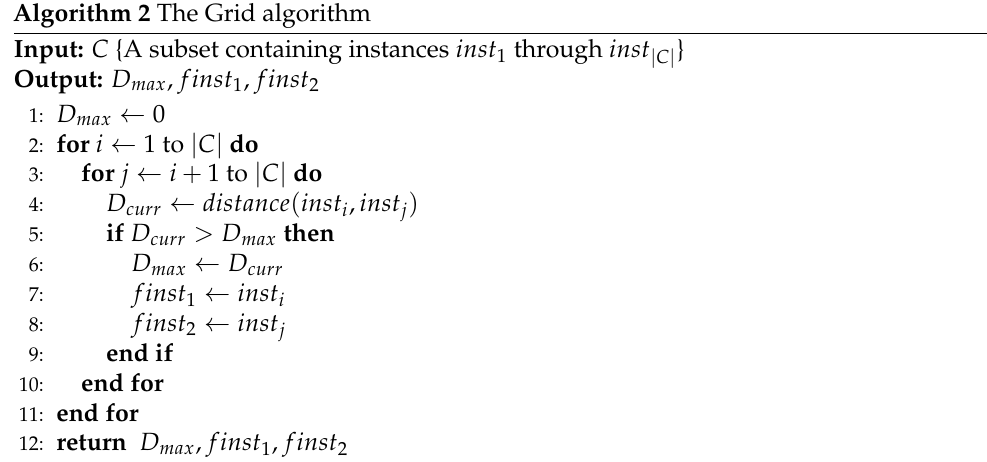
Algorithm 2 The Grid